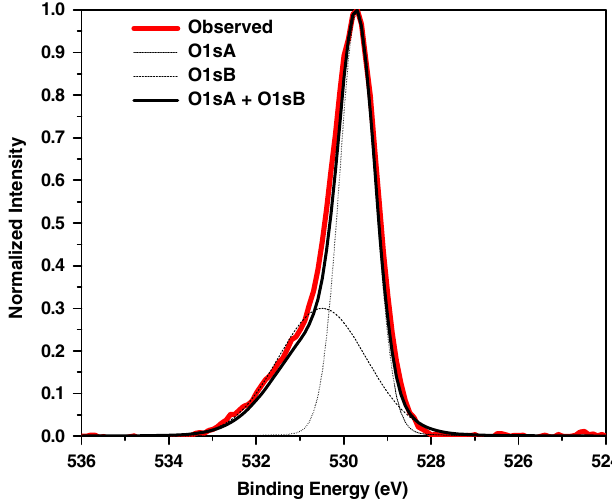
FIG. 8. Normalized XPS spectrum of oxygen 1 s for the Nb sample after Ar = Cl 2 plasma treatment. The same sample is used in Fig. 7 (before treatment) and Fig. 8 (after treatment). FIG. 9. AFM scan ( 50 (cid:1) m (cid:1) 50 (cid:1) m ) of BCP prepared